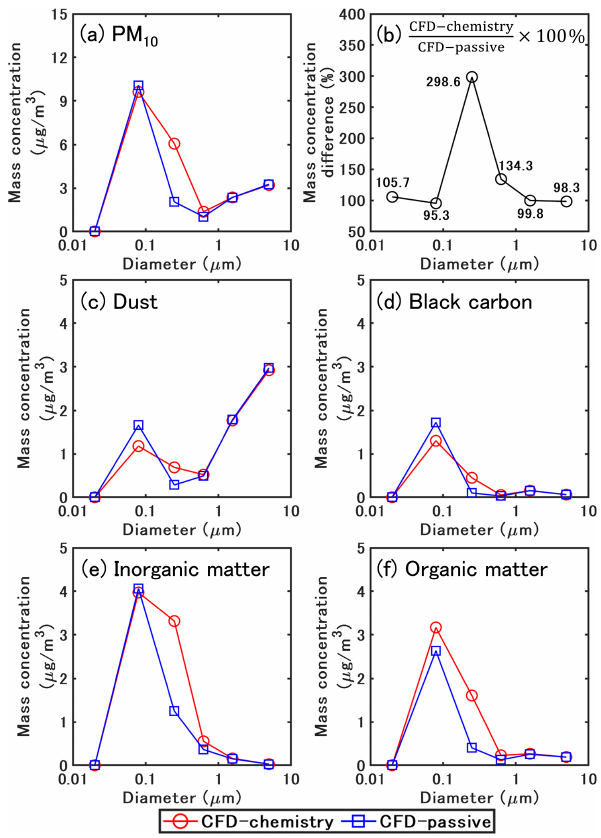
Figure 17. Time-averaged size distribution of PM 10 for different chemical species from 05:00LT to